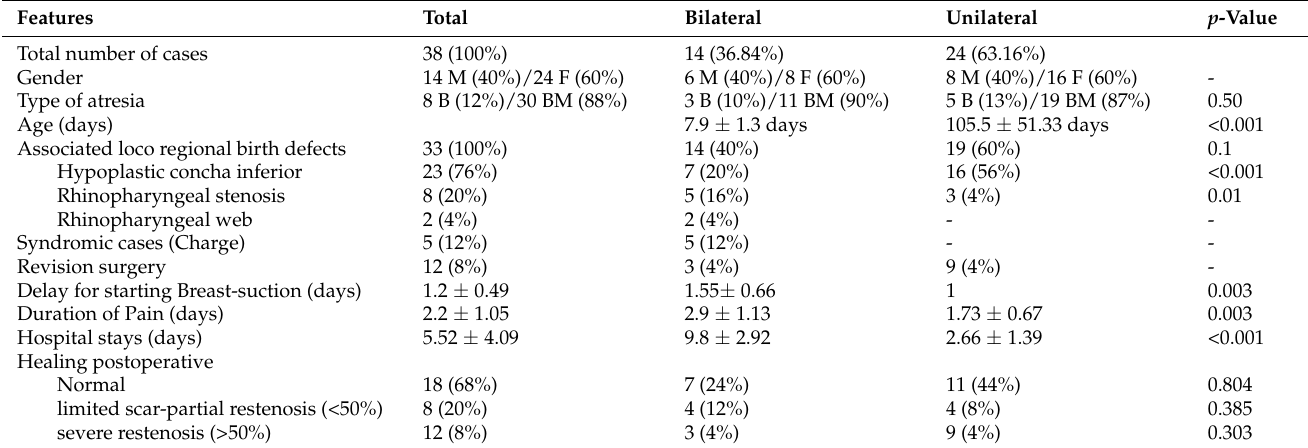
Table 1. The main demographic features are divided according to each choanal